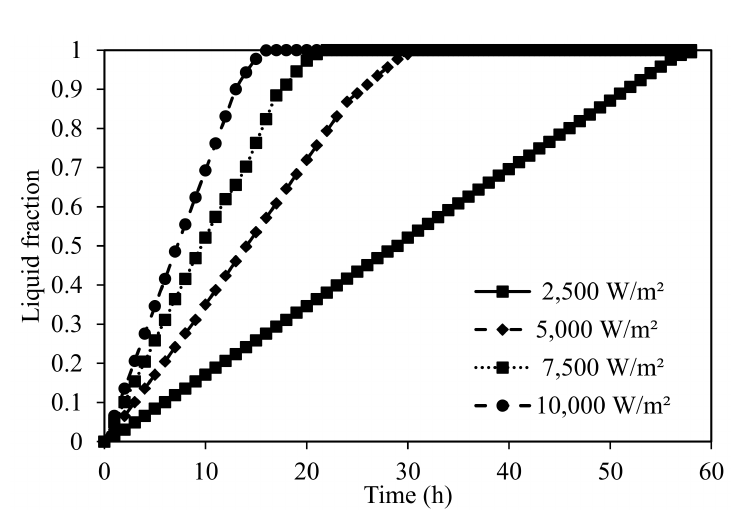
Figure 9. Effect of heat flux on charging of